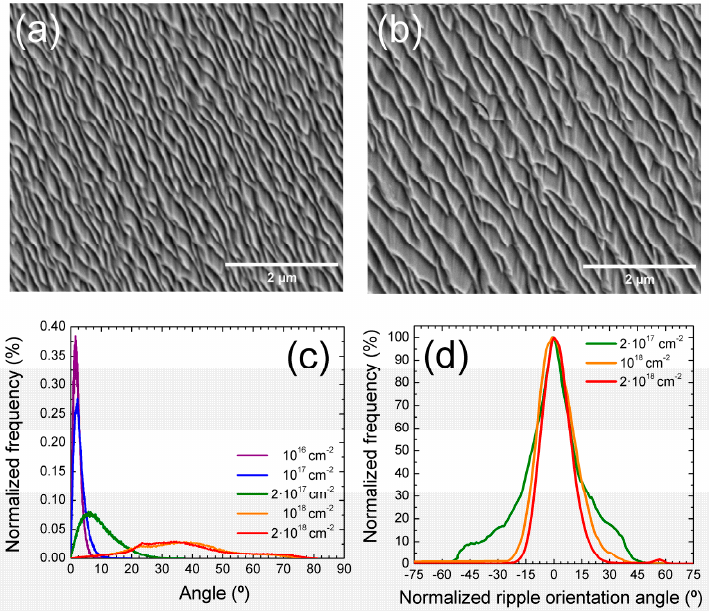
Figure 3. ( a,b ) SEM images taken on the samples irradiated at 10 18 cm − 2 and 2 × 10 18 cm − 2 , respectively. ( c ) Surface angle distribution obtained from the AFM images for the irradiated samples. ( d ) Normalized ripple orientation angle distribution obtained from the corresponding SEM images, except for the lowest fluence case where it was obtained from the AFM data.